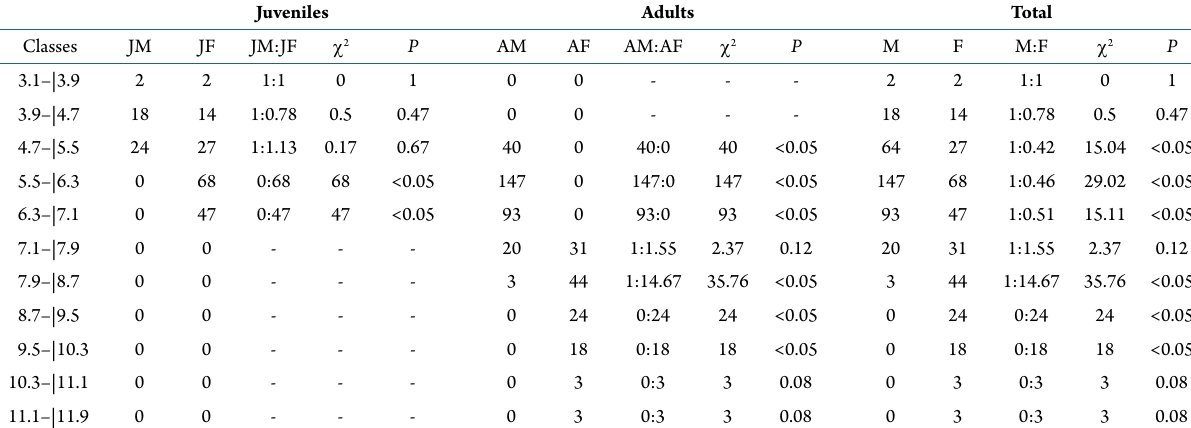
Figure 3. Macrobrachium jelskii (Miers, 1877). (A) Size at morphological sexual maturity for males; (B) size at morphological sexual maturity for females. Table 2. Macrobrachium jelskii (Miers, 1877). Number of juvenile males (JM), adult males (AM), total males (M), juvenile females (JF), adult females (AF), total females (F) and sex ratio for each group (JM:JF, AM:AF, M:F), along the classes size, with Chi-square values (χ2) and probability ( P